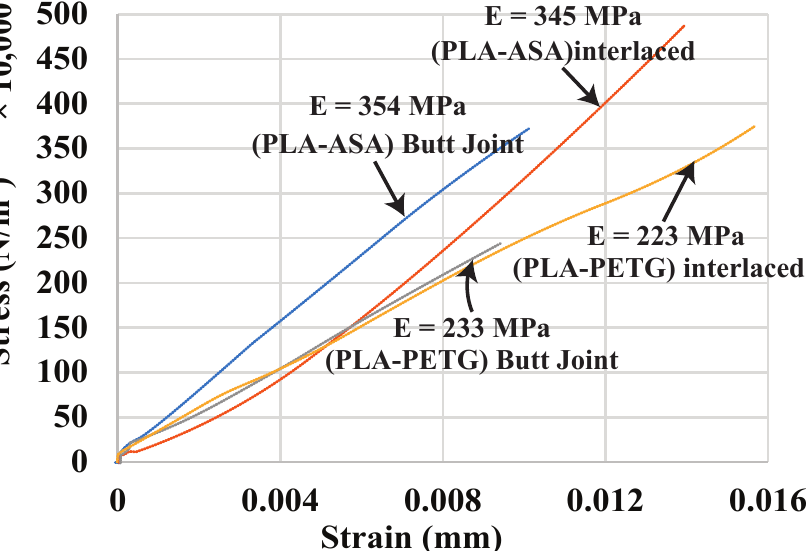
Figure 14. Tensile test curves for different material combinations and joint configurations.